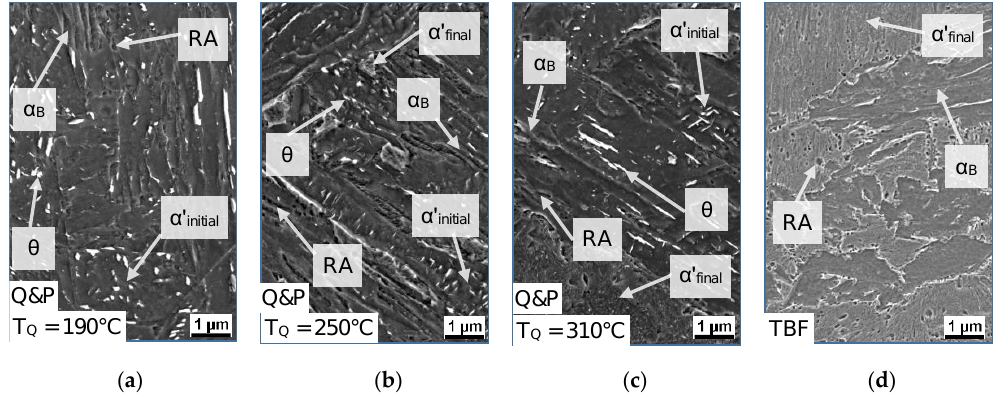
Figure 7. SEM images of the ( a – c ) Q&P samples ( T Q = 190, 250, and 310 °C) and ( d ) TBF sample at a T P ( T B ) of 400 °C (magnification 5000×).